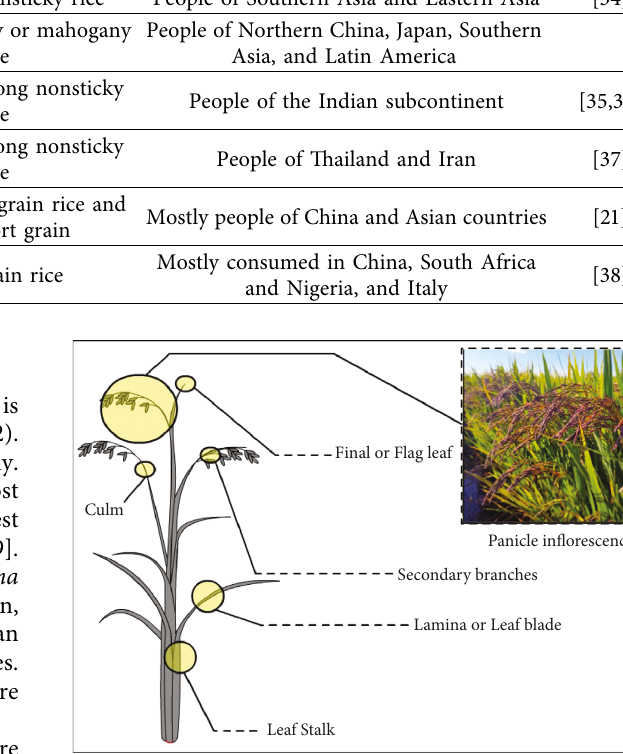
Figure 2: Formation of black